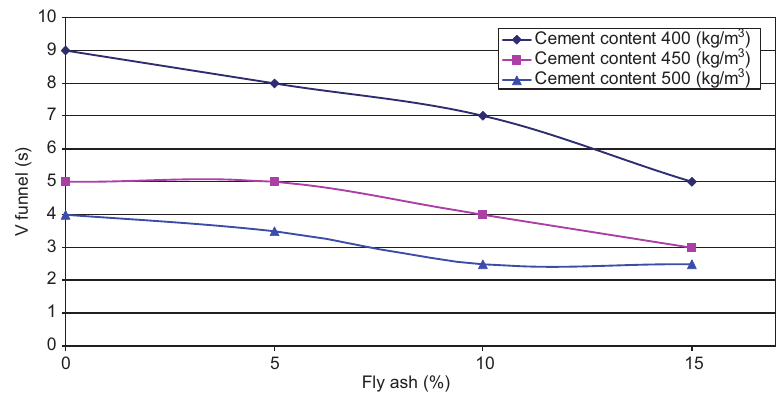
Figure 7 V-funnel flow time changes for different mixes of HPSCC.